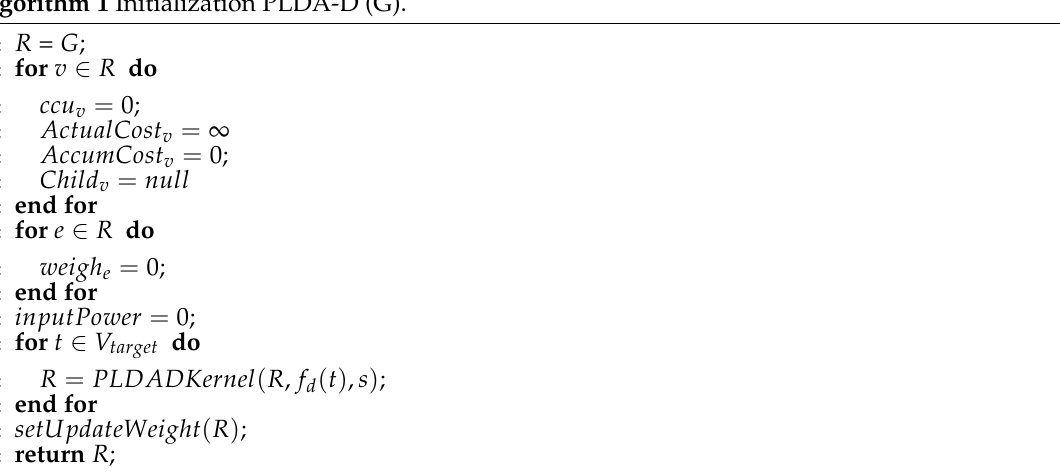
Algorithm 1 Initialization PLDA-D